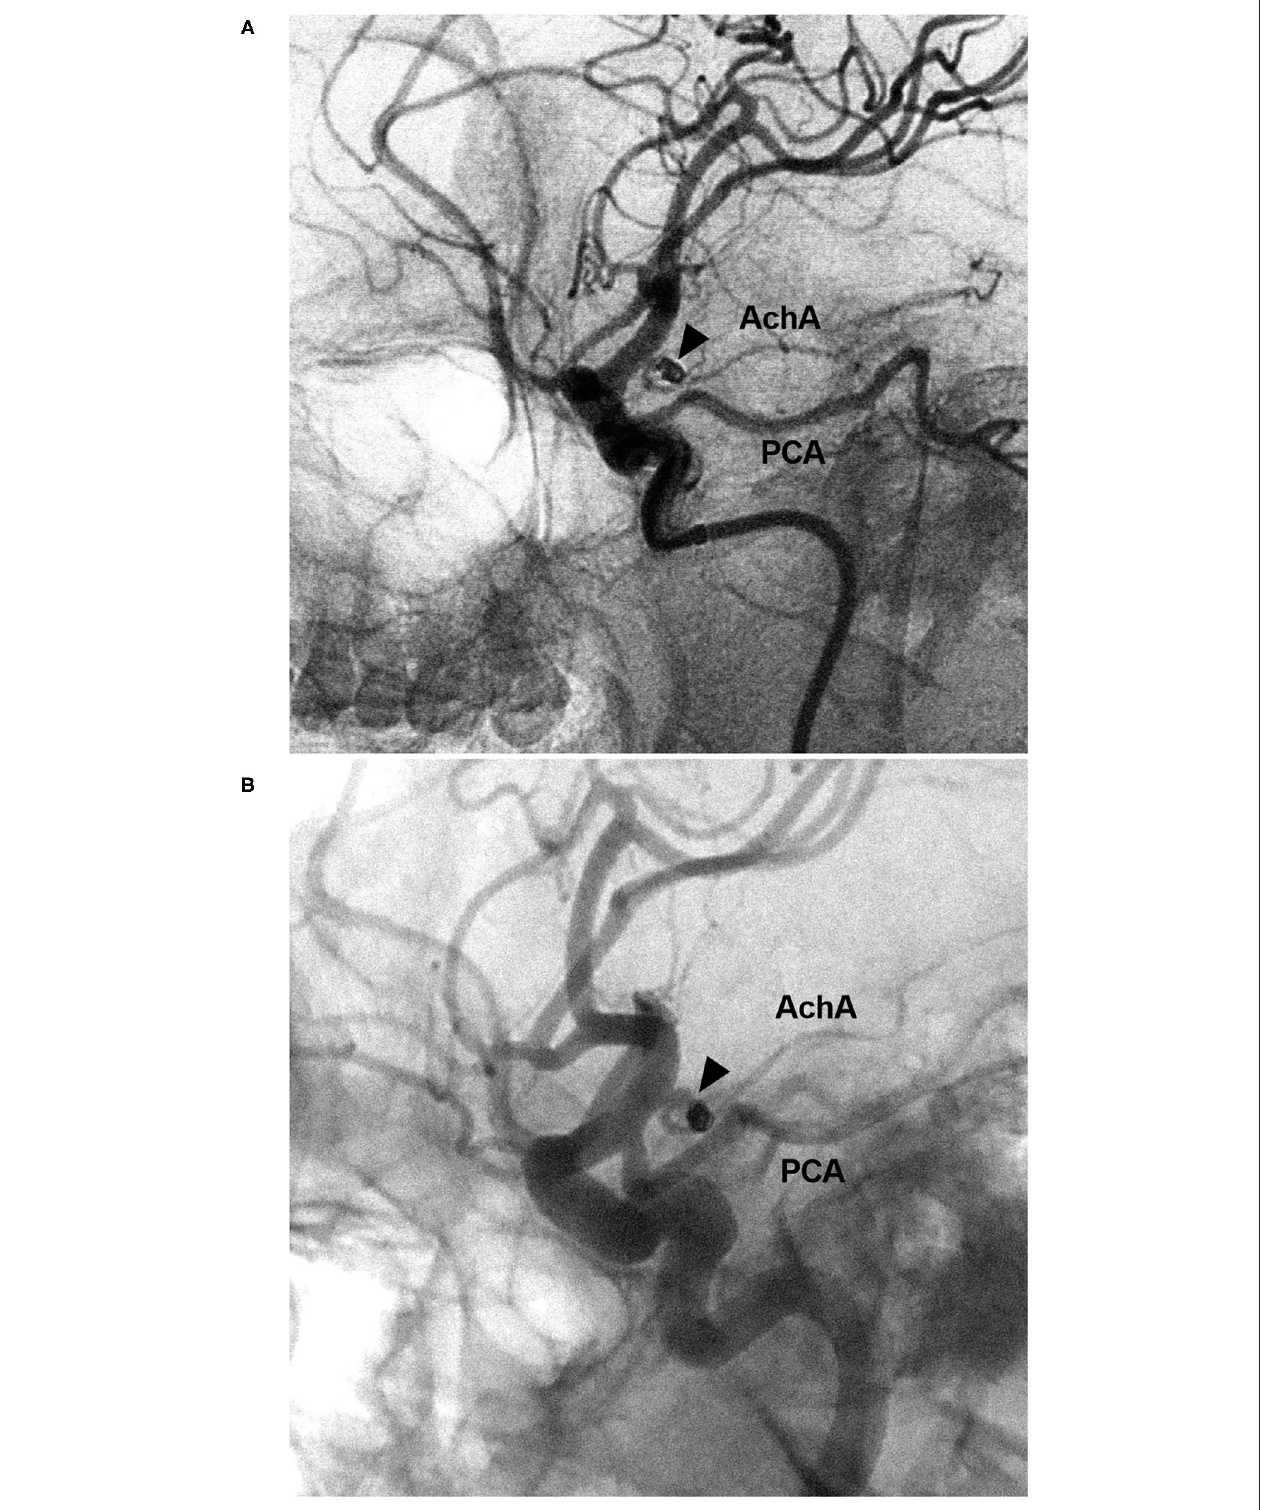
FIGURE 8 | EVT of the AchA aneurysm with recurrence. (A) DSA of the ICA showing a type II AchA aneurysm (triangle) that was coiled with MRCC grade I. (B) Follow-up DSA showing aneurysm recurrence (triangle), the coils were compressed, with MRCC grade II. AchA, anterior choroidal artery; DSA, digital subtraction angiography; EVT, endovascular treatment; ICA, internal carotid artery; MRCC, Modified Raymond-Roy Classification; PCA, posterior cerebral artery.